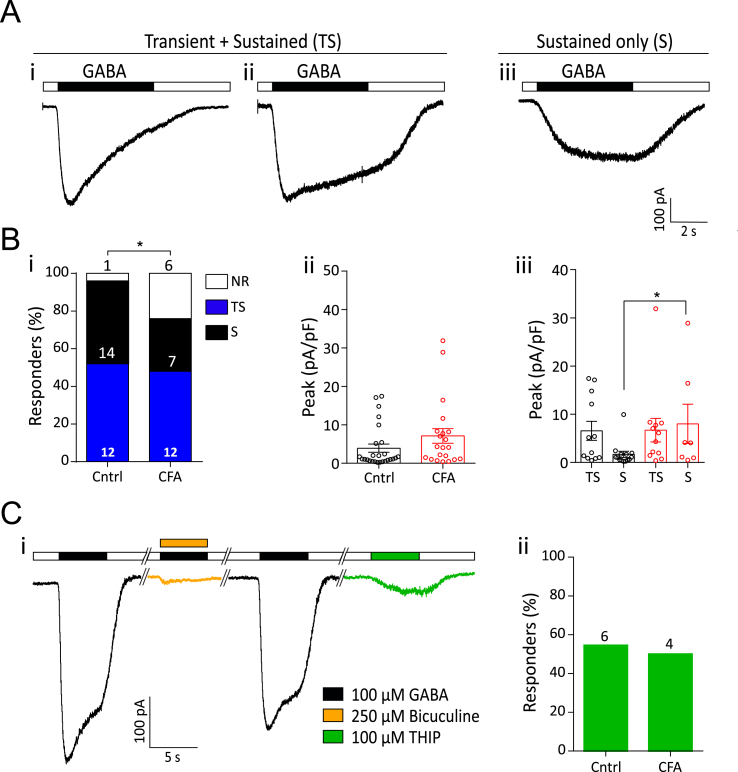
GABA-evoked currents from knee neurons after acute inflammation. A) Representative traces of 100 μM GABA-evoked currents showing both transient and sustained phases (i, ii) and currents with only a sustained phase (iii). B (i) Percentage frequency of GABA-evoked transient + sustained currents (blue bars), sustained currents (black bars) and non-responders (white bars) in Cntrl and CFA neurons. (ii) Peak current density of all GABA-evoked currents (Cntrl: n = 26, CFA: 19) and (iii) GABA-evoked currents split into TS and S type (Cntrl: black dots; CFA: red dots). TS = transient + sustained currents, S = sustained only currents, error bars indicate SEM, * indicates p < 0.05, unpaired t-test. C) i - Example trace of bicuculline block (yellow) of GABA-evoked currents and THIP-evoked current (green) in a single neuron. ii – percentage frequency of Cntrl (n = 11) and CFA (n = 8) neurons with a GABA response that also responded to THIP. The numbers above the bars indicate the number of responsive neurons. (For interpretation of the references to colour in this figure legend, the reader is referred to the Web version of this article.)